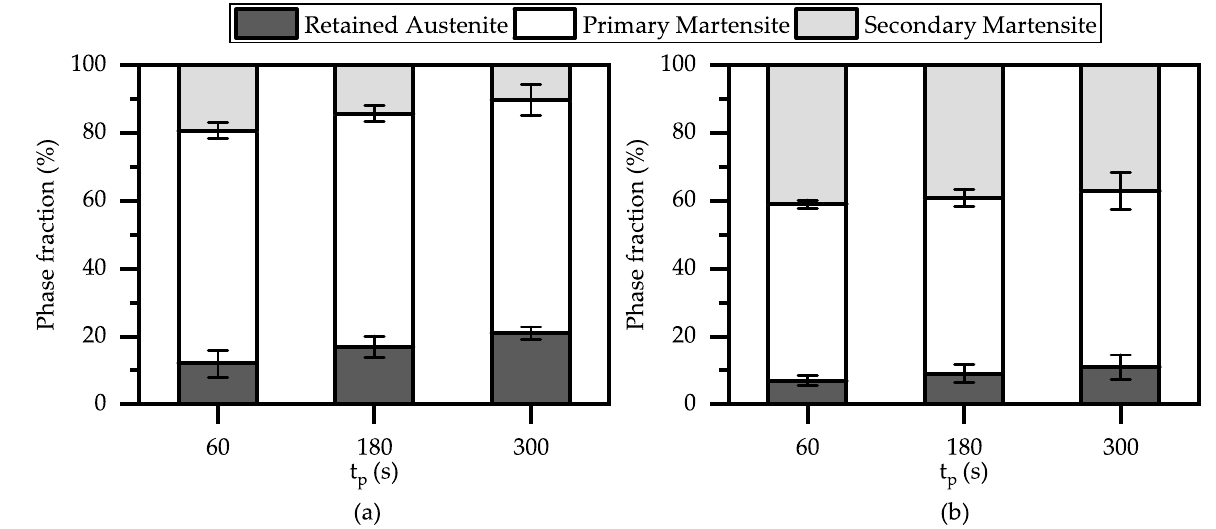
Figure 10. Final phase fractions in dependence of tp for ( a ) T Q = 150 °C and ( b ) T Q = 170